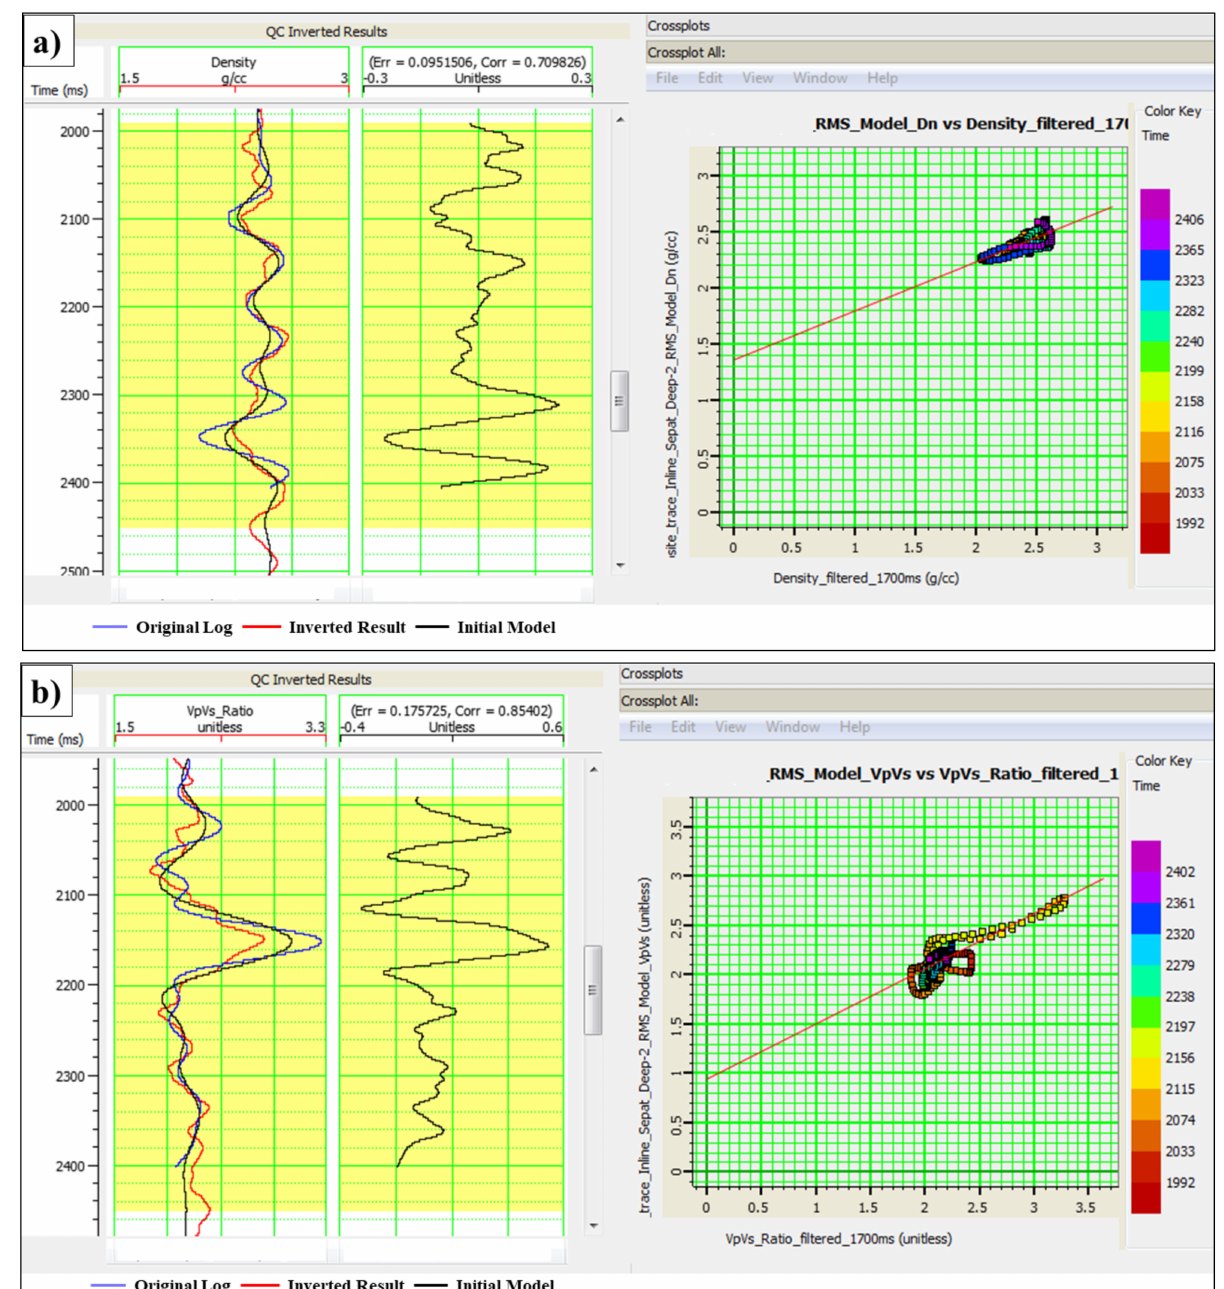
Figure 16. ( a ) Simultaneous pre-stack inversion analysis plot for density property for well XD-2 within error calculation time window (yellow colour). The correlation between the original (blue) and inverted (red) density logs is 0.70. ( b ) Simultaneous pre-stack inversion analysis plot for Vp/Vs ratio property for well XD-2 within error calculation time window (yellow colour). The correlation between the original (blue) and inverted (red) Vp/Vs ratio logs is